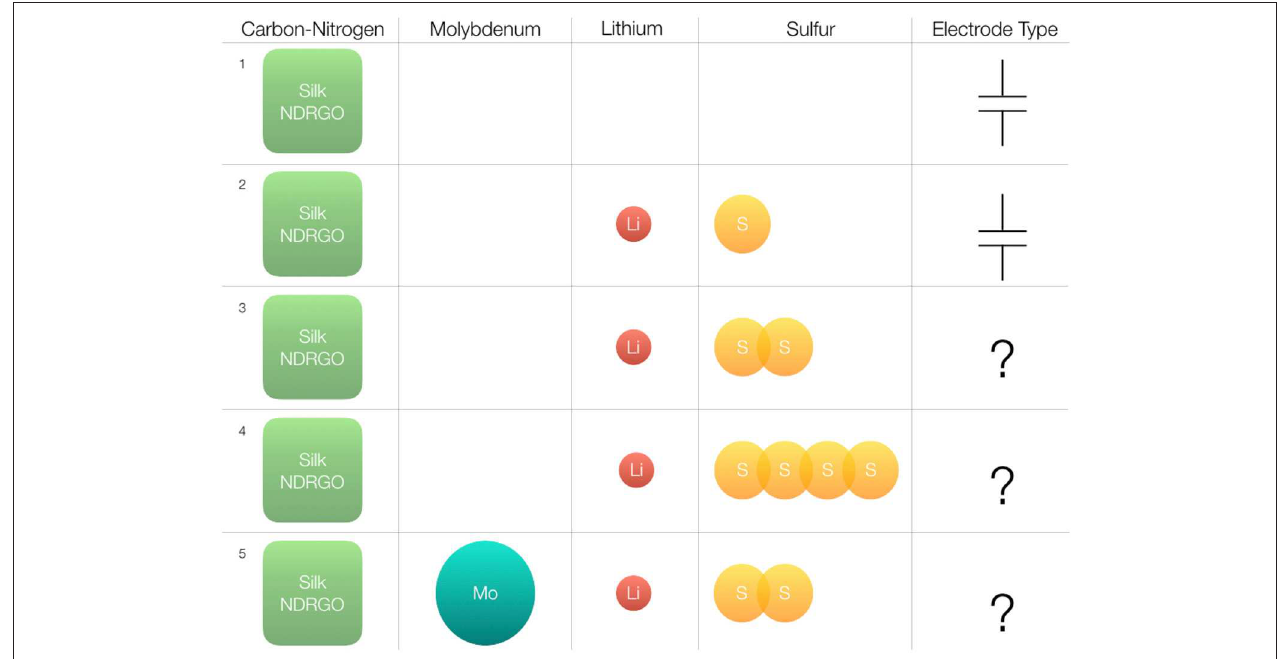
FIGURE 1 | Overall experimental design and the strategies followed to develop a stable silk NDRGO, Li, S electrode. The heavily nitrogen doped reduced graphene oxide (NDRGO) derived from silk is used as a conductivity cage. Superscript 1 indicates NDRGO, a supercapacitor electrode. Superscript 2, stands for NDRGO-Li-S composite obtained from equimolar doping of Li and S on the NDRGO matrix. Superscript 3, stands for 1M Li and 2M S doping on the NDRGO matrix, i.e., NDRGO-Li-2S. Superscript 4, stands for 1M Li and 4M S doping on the NDRGO matrix, i.e., NDRGO-Li-4S. Superscript 5, stands for Mo, 1M Li and 2M S doping on the NDRGO matrix, i.e.,